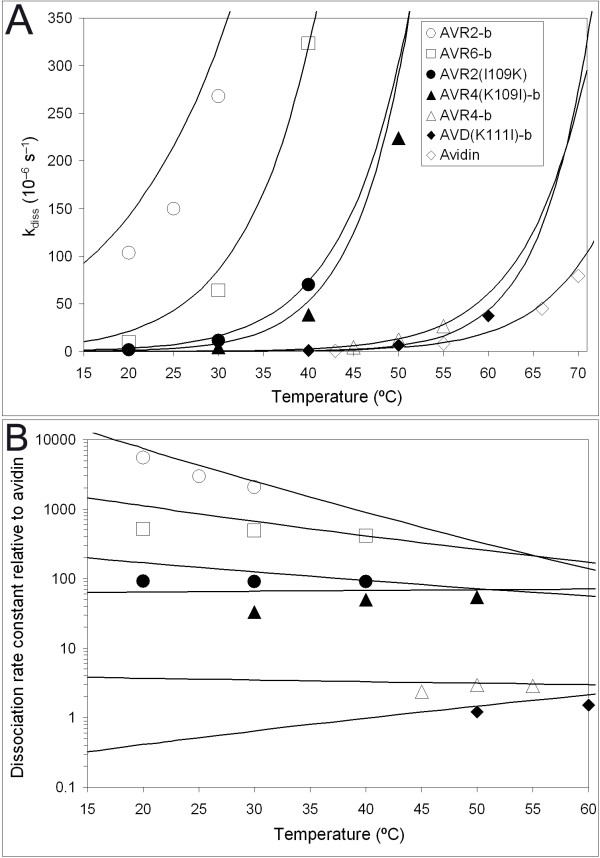
Biotin dissociation analysis. (A) Temperature-dependence of biotin dissociation rates measured by the [3H]biotin dissociation assay. Radiobiotin dissociation rate constants measured for the proteins are plotted as a function of temperature. The models for dissociation rate constants obtained by global fit analysis [41] are shown by lines and the determined individual dissociation rates by symbols. The dissociation rate constants determined previously for avidin and AVR4-b are also shown [39]. (B) Relative dissociation rate constants of the AVRs and avidin mutant K111I compared to that of avidin. The individual dissociation rates as well as global fit analysis models of the dissociation rate are divided by the dissociation rate constants of avidin obtained from global fit analysis. The data are plotted using a logarithmic y-axis.